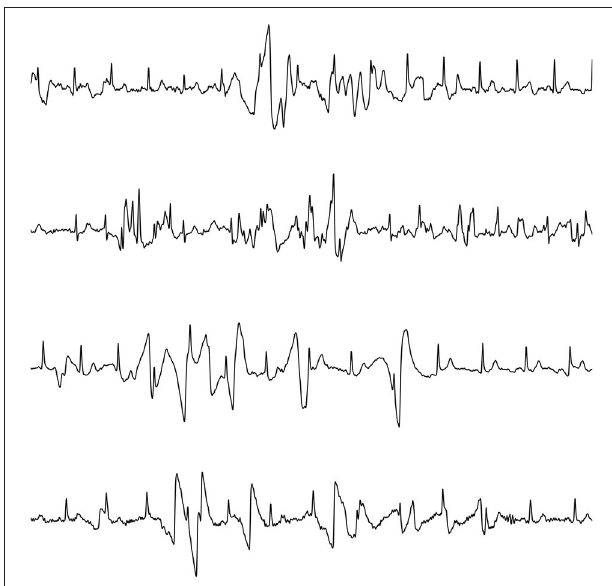
FIGURE 1 | Examples of transient noise observed in ECG screening with a handheld